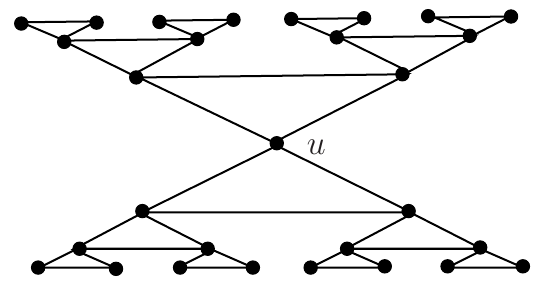
Fig. 2: The graph G 3 which has oriented radius 6 and oriented diameter